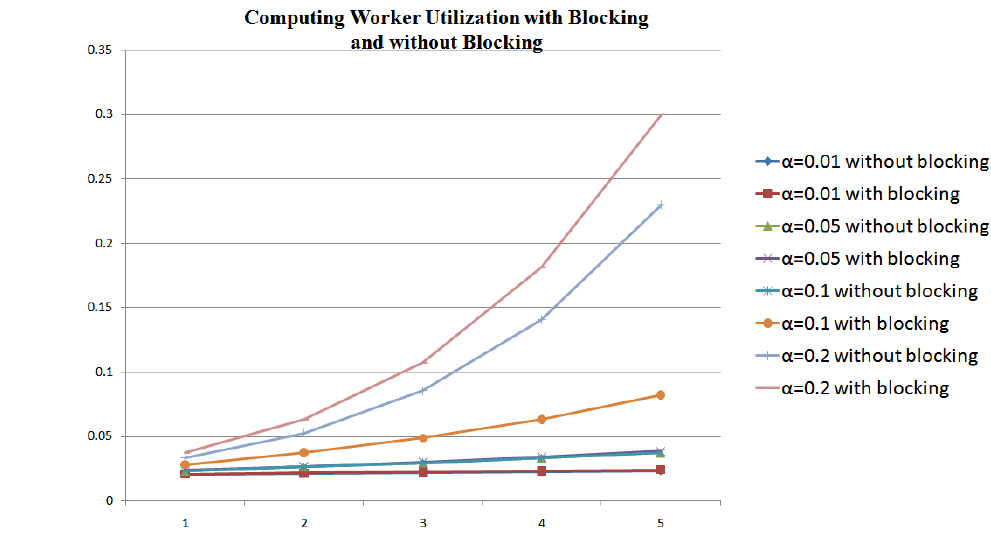
Figure 5. Computing Worker CPU Usage when (cid:22)